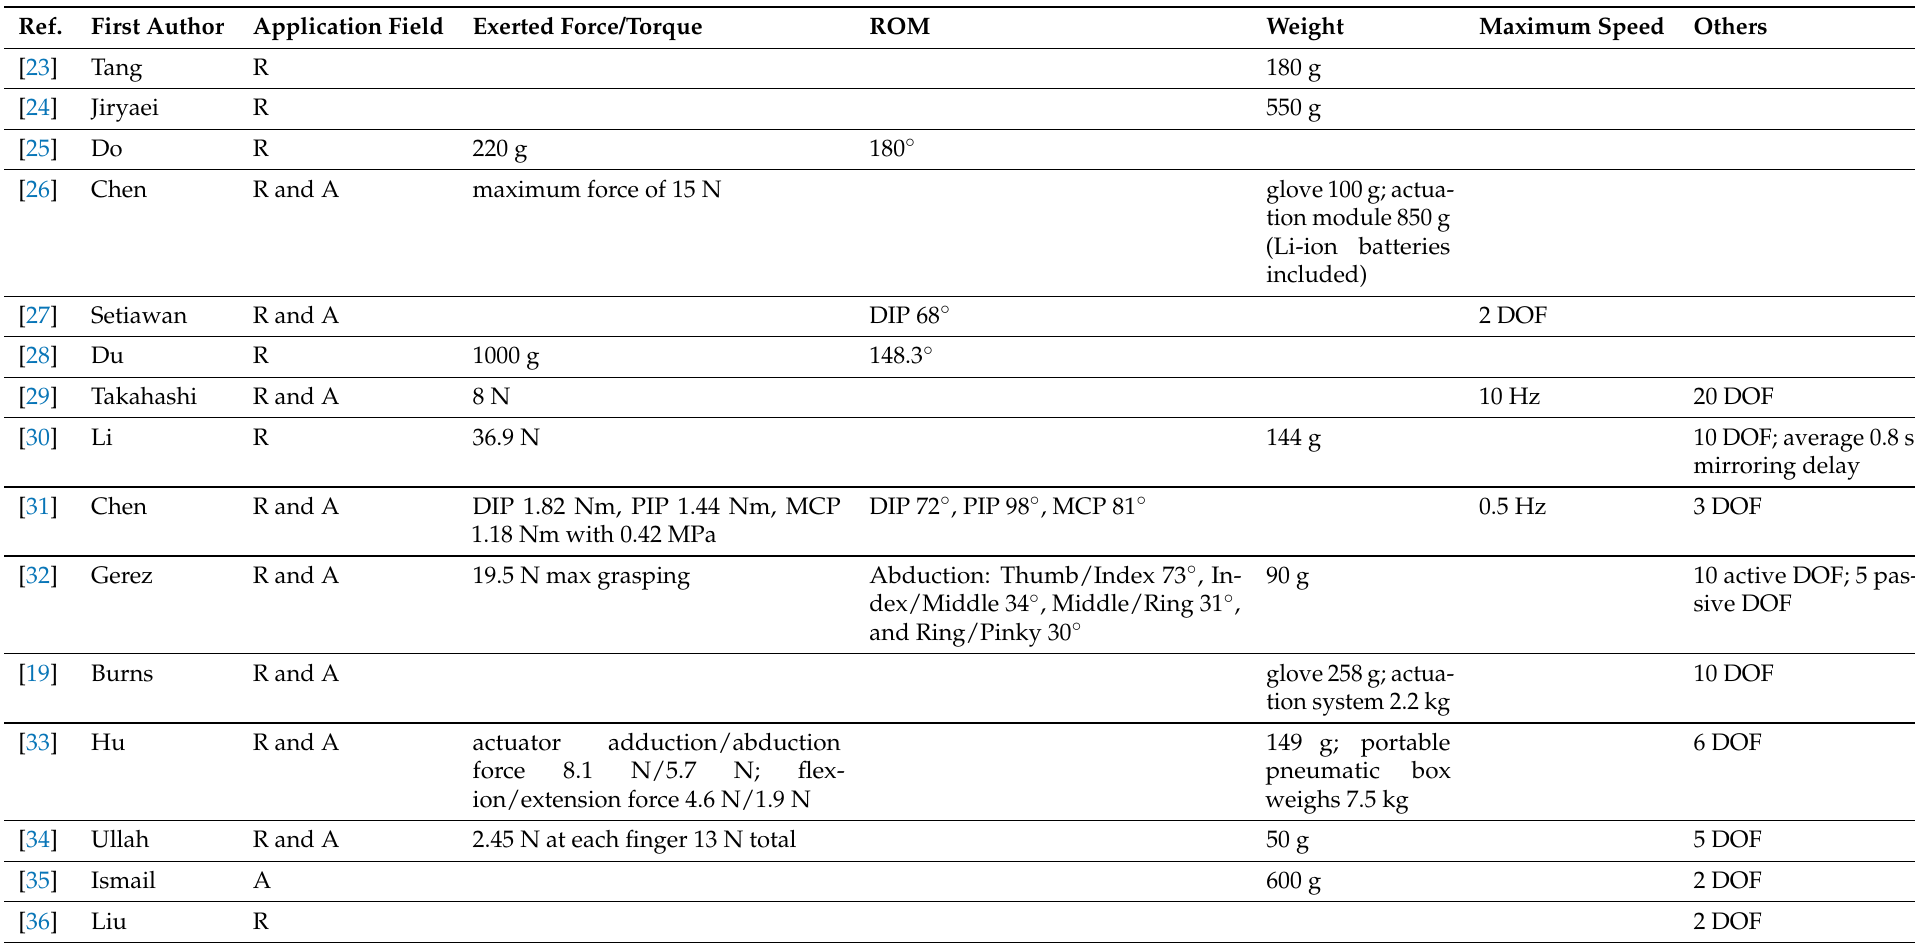
Table 2. Main technical data of soft gloves. The abbreviations adopted in the table are: R = Rehabilitation, A = Assistance, DIP = distal interphalangeal, PIP = proximal interphalangeal, MCP =